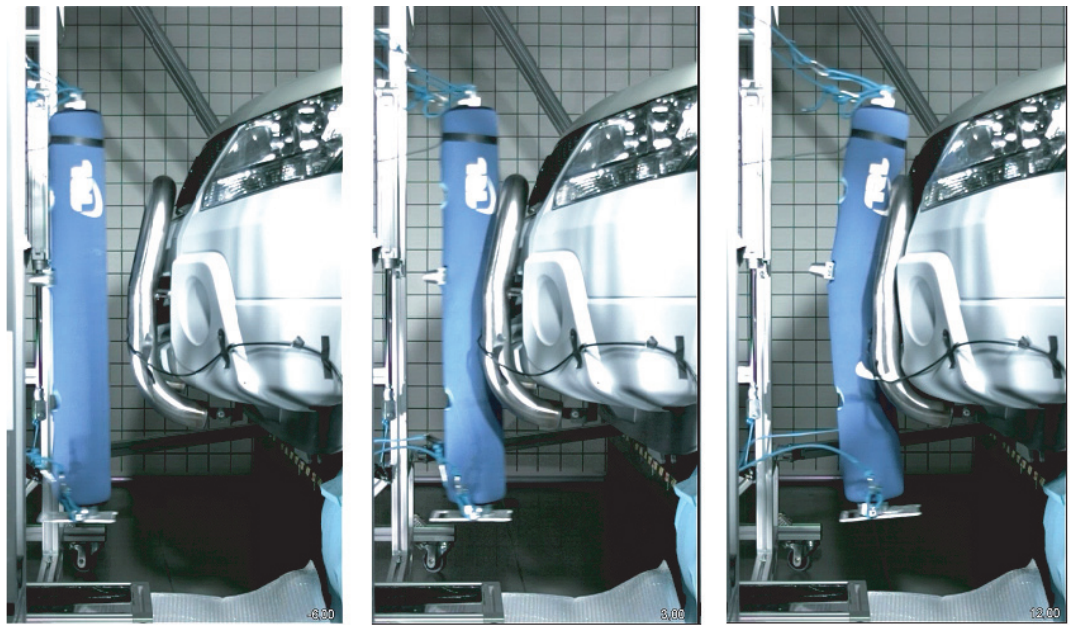
Fig. 6. Lower legform impact